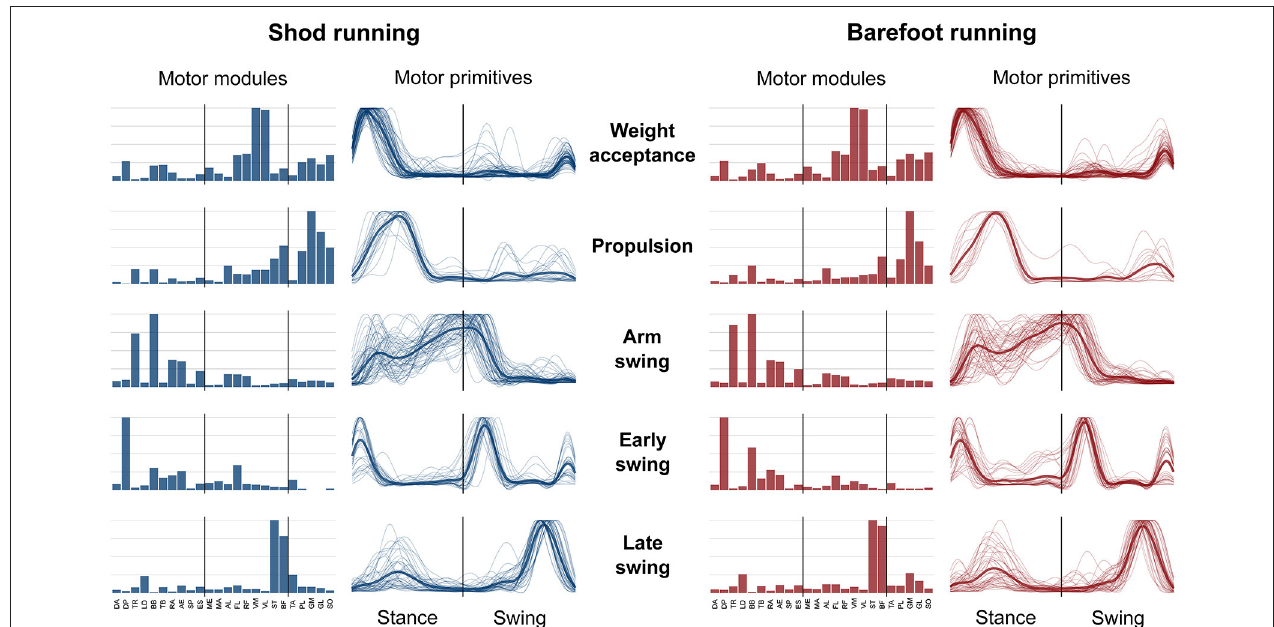
FIGURE 4 | Motor modules and motor primitives for shod and barefoot running at the comfort speed. The motor modules are presented on a normalized y-axis base. For the motor primitives, the x-axis full scale represents one gait cycle (stance and swing normalized to the same amount of points and divided by a vertical line) and the y-axis the normalized amplitude. The motor modules represent the average normalized values across all the participants. The mean motor primitives are represented with a thick black line, while all the trials are denoted by thin gray lines.